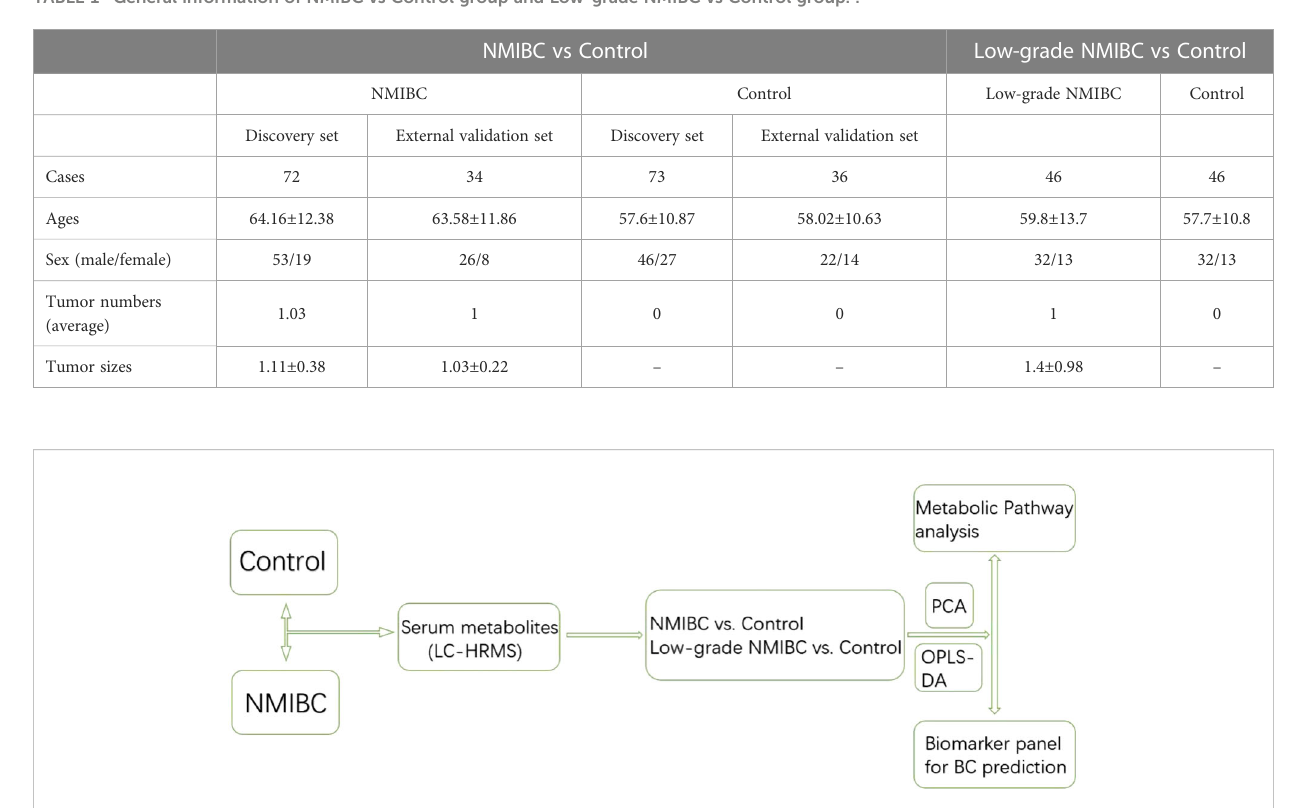
FIGURE 1 The work fl ow of the